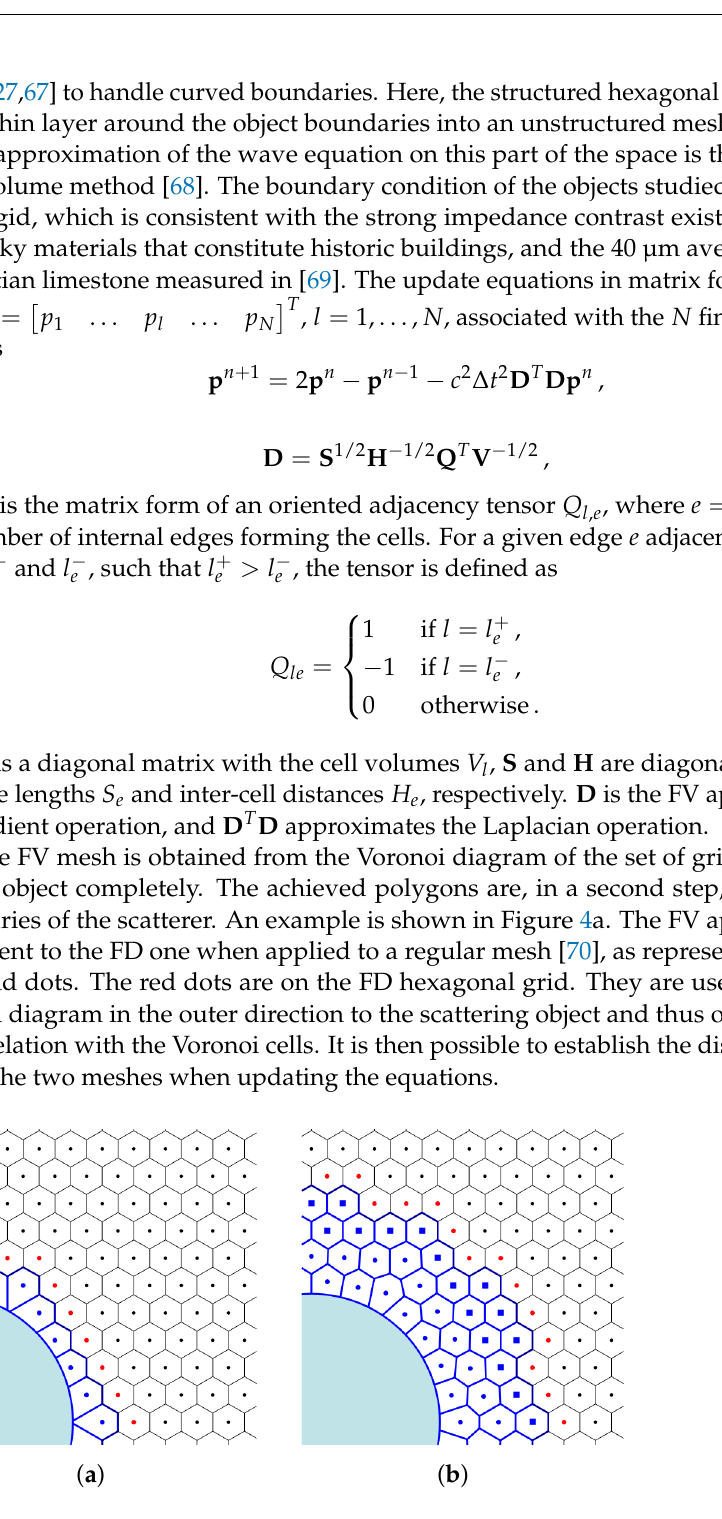
Figure 4. Examples of hybrid meshes in proximity to a curved boundary. ( a ) Voronoi diagram of grid points enclosing the boundary. ( b ) Centroidal Voronoi diagram after 10 iterations of Lloyd’s method. Voronoi cells are shown with blue edges, and their corresponding generating sites with blue dots and square. They are clipped by the boundary of the object shown in cyan, and bounded in the outer direction by the regular grid points enclosing them, shown with red dots. Regular hexagonal grid is shown in